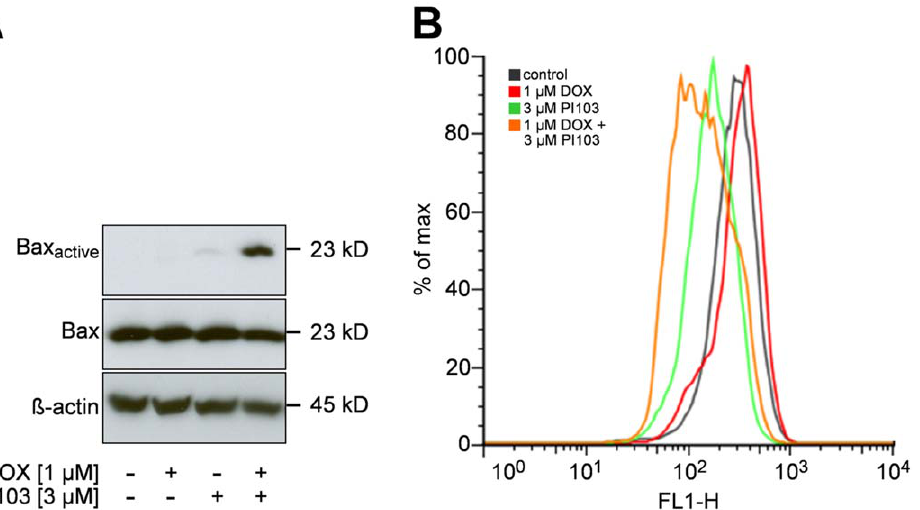
Figure 3. PI103 and DOX cooperate in Bax activation and cytochrome c release. RD cells were treated with 1 m M DOX and/or 3 m M PI103 or the solvent. A) Activation of Bax was analysed by immunoprecipitation. B) Cytochrome c release was assessed by FACS at 530 nm (red line: 1 m M DOX; green line: 3 m M PI103; orange line: 1 m M DOX plus 3 m M PI103; black line: solvent). The data are expressed as the percentage of the maximum (max) number of positive cells and represent one of three independent experiments, measured in